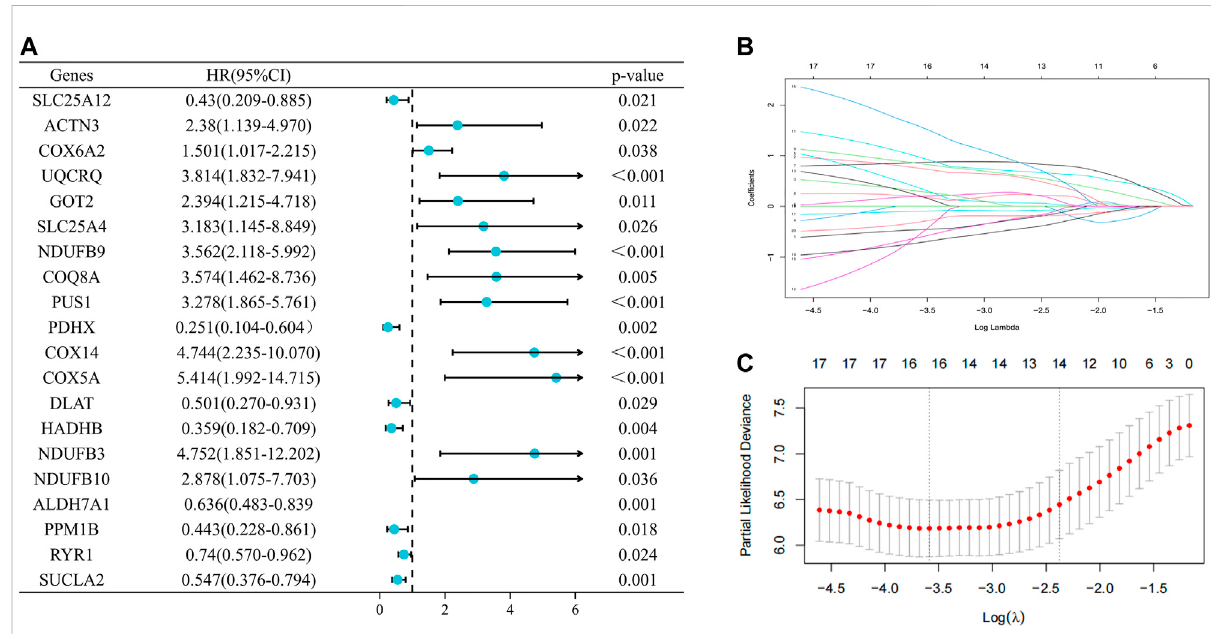
FIGURE 5 Selection ofprognosis-relatedDE-LRGstoconstruct prognosticmodels (A) .TheforestplotpresenttheDE-LRGsassociatedwithprognosis via univariate Cox analysis (B ,C) . Lasso analysis further screened 14 genes with the optimal lambo